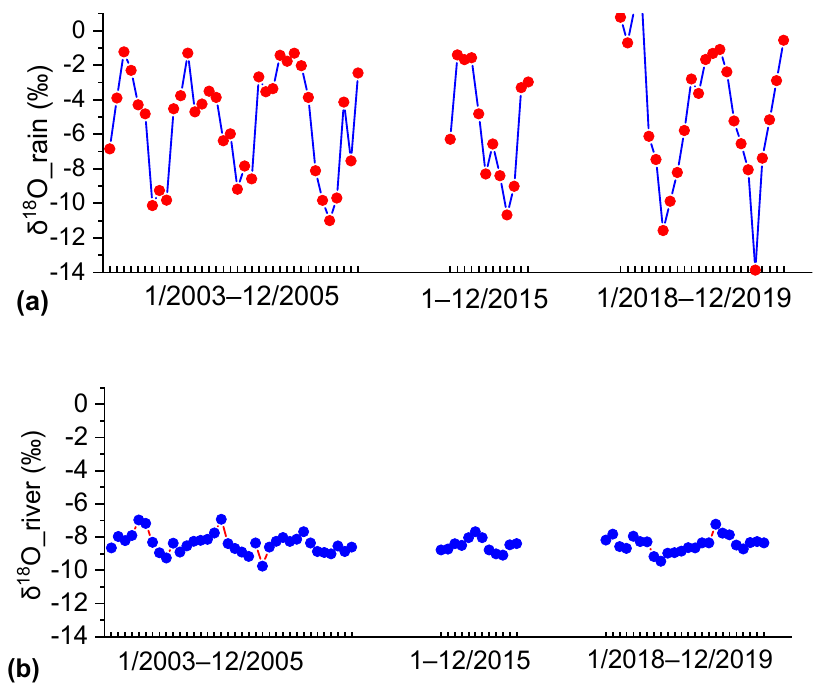
Figure 3. δ 18 O in rainwater ( a ) and in river water ( b ).